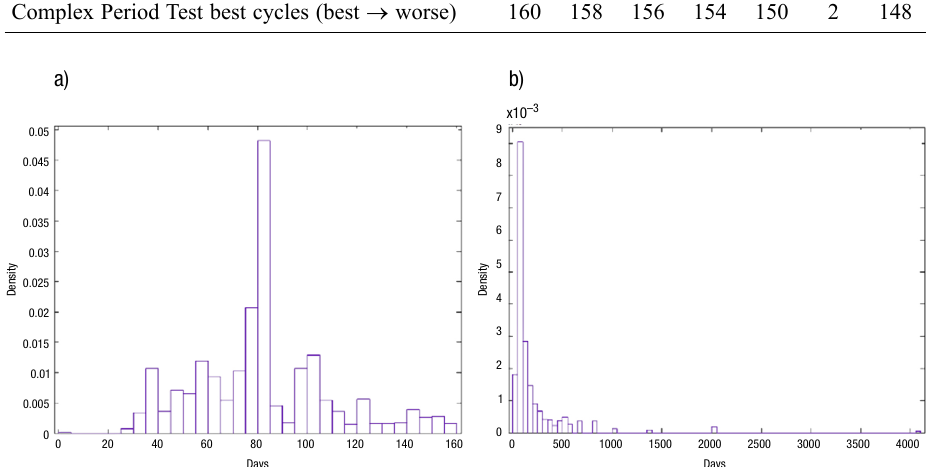
Table 2. Results of Complex Period Test – the best cycles (number of days in one period) Complex Period Test best cycles (best → worse)